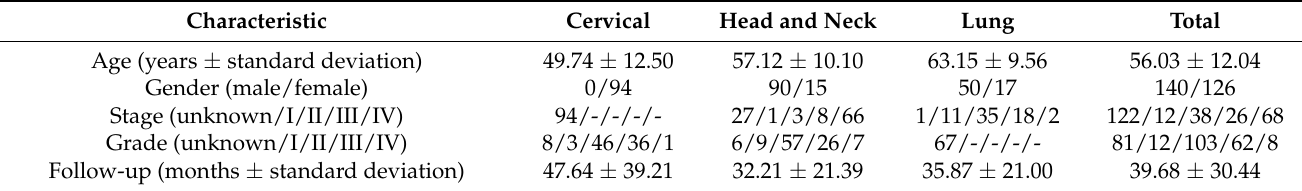
Table 1. Overview of analysis squamous cancer cell datasets.